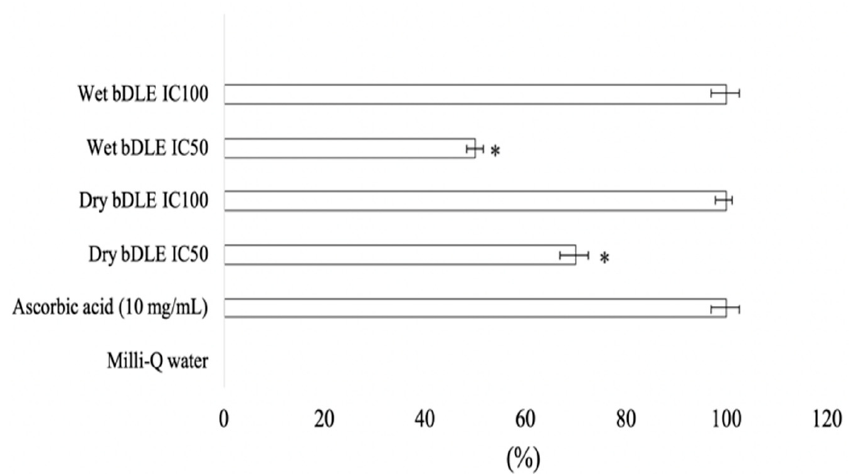
Figure 9. Antioxidant capacity of wet and dry bDLE by MTT method. Wet and dry bDLE (8 mg/mL) were incubated with MTT (1 mg/mL) for 10 min at 37 ◦ C. Absorbance was measured at 570 nm wavelength to detect formazan, the MTT salt-reduced form. Antioxidant capacity (%) was determined by comparison against ascorbic acid reduced MTT absorbance (100%). All values shown are the means of ten determinations (mean ± SD); SD: standard deviation. Statistical significance was determined by one-way ANOVA followed by the Dunnett’s post hoc test (* p <